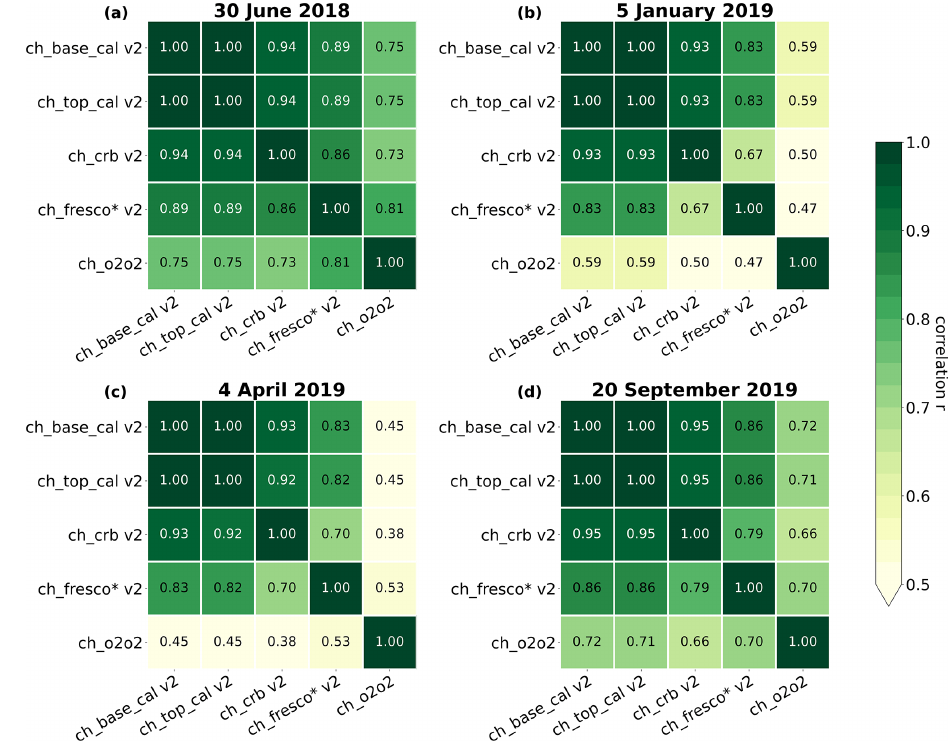
Figure 11. Tabular intercomparison of the correlations between the version 2 cloud heights from ROCINN CAL base and top, ROCINN CRB, FRESCO from the TROPOMI NO 2 product (ch_fresco*), and O 2 –O 2 for China and (a) the summer day, (b) the winter day, (c) the spring day, and (d) the autumn